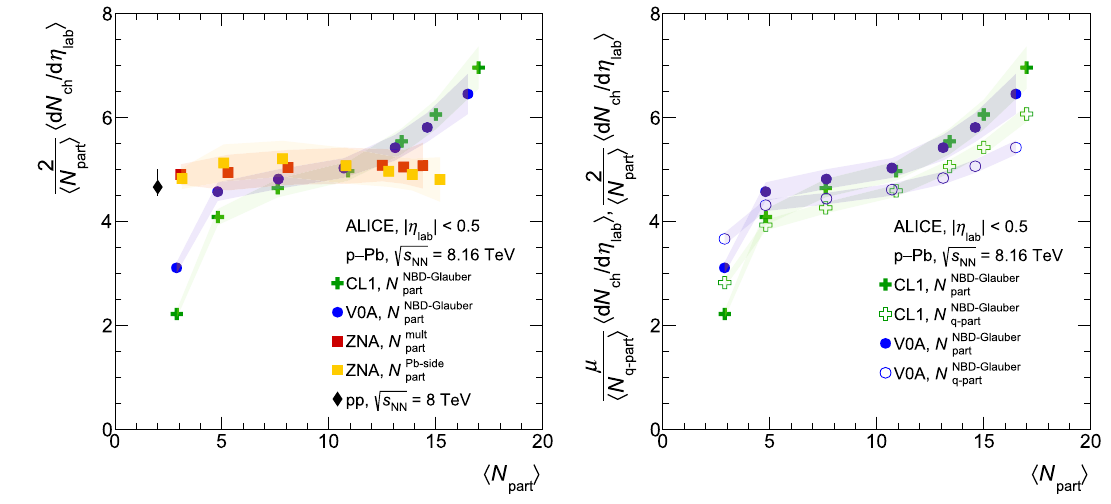
√ (cid:3) d N / d η (cid:4) in p–Pb collisions at = 8 . 16 TeV and pp at 8 TeV [35] as a function of (cid:3) N s ch lab NN N part (cid:4) (cid:3) d N / d η (cid:4) for N = 5, open points, with μ = 4 . ch lab c N q − part (cid:4)